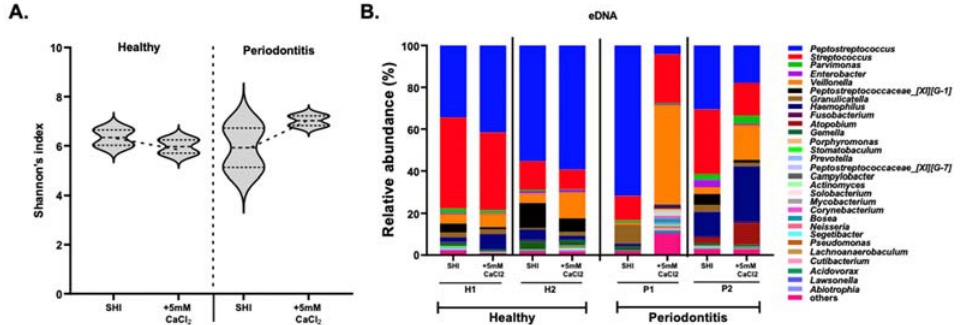
Figure 6. The effect of CaCl 2 supplementation on eDNA. ( A ) Alpha diversity analysis of eDNA rep ‐ resentation of biofilms derived from the saliva of healthy (H) and periodontitis (P) patients. The biofilms were grown in SHI medium (SHI) and SHI medium + 5 mM CaCl 2 (+5 mM CaCl 2 ). Violin plots representing the alpha diversity of eDNA in the absence and presence of +5 mM CaCl 2 are shown. The median line represents the average while the dotted lines represent minimum to maxi ‐ mum ( B ) Genus ‐ level microbial composition of eDNA in the healthy (H1, H2) and periodontitis (P1, P2) patients as revealed by 16S rRNA gene sequencing. Bar plots represent the relative abundance of genera present in the oral biofilm communities formed in SHI medium (SHI) and SHI medium +5 mM CaCl 2 (+5 mM CaCl 2 ).